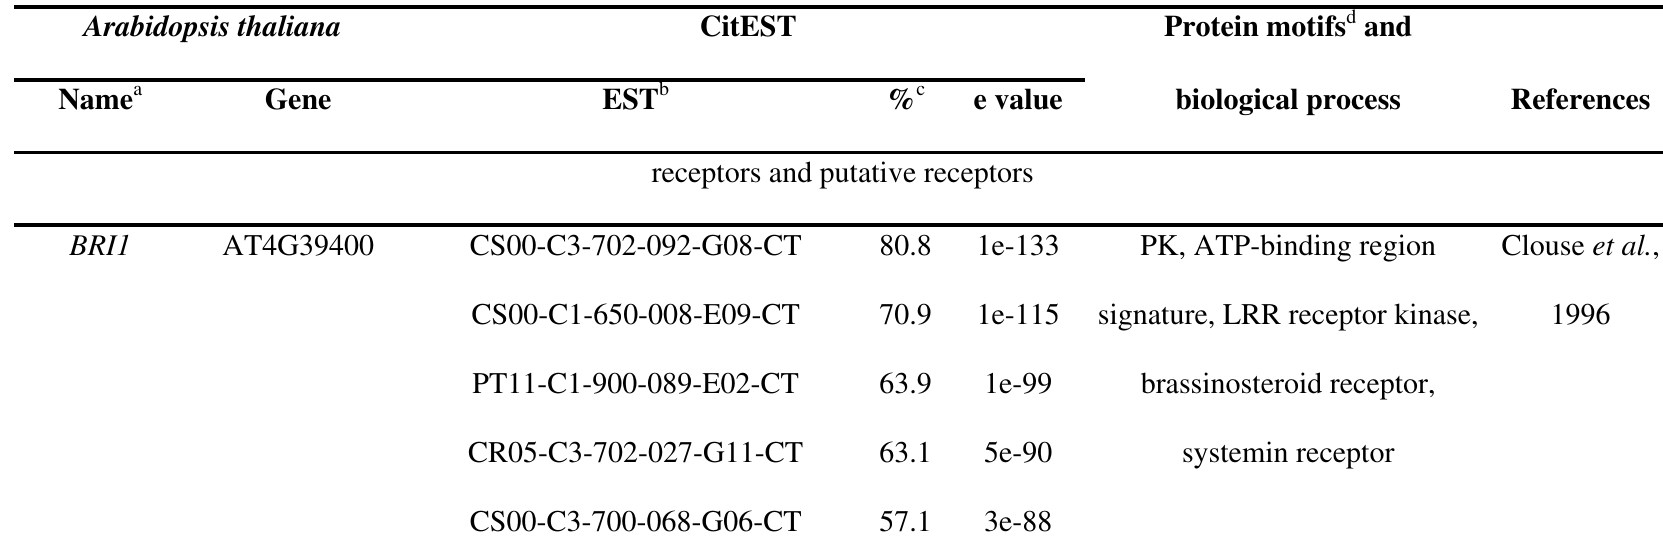
Table S5 – Citrus ESTs with homology to genes involved in brassinosteroid-initiated signal transduction in Arabidopsis thaliana